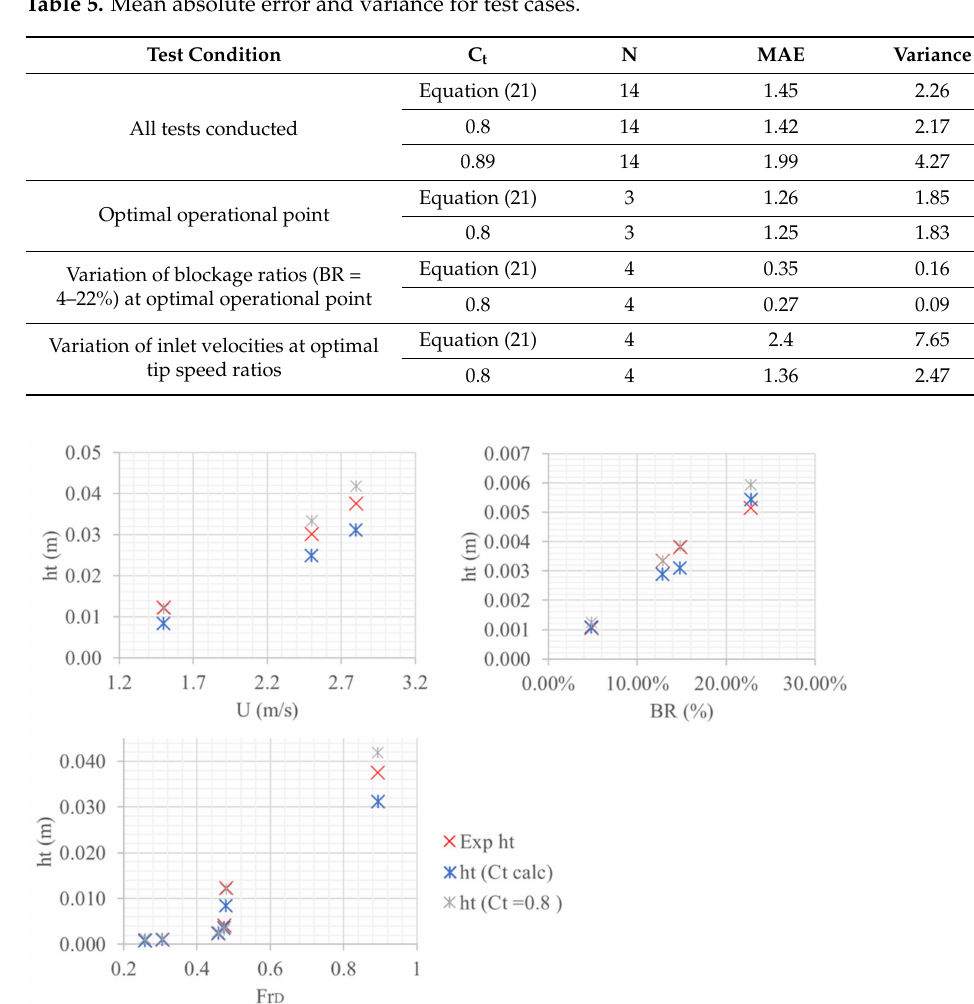
Table 5. Mean absolute error and variance for test cases.